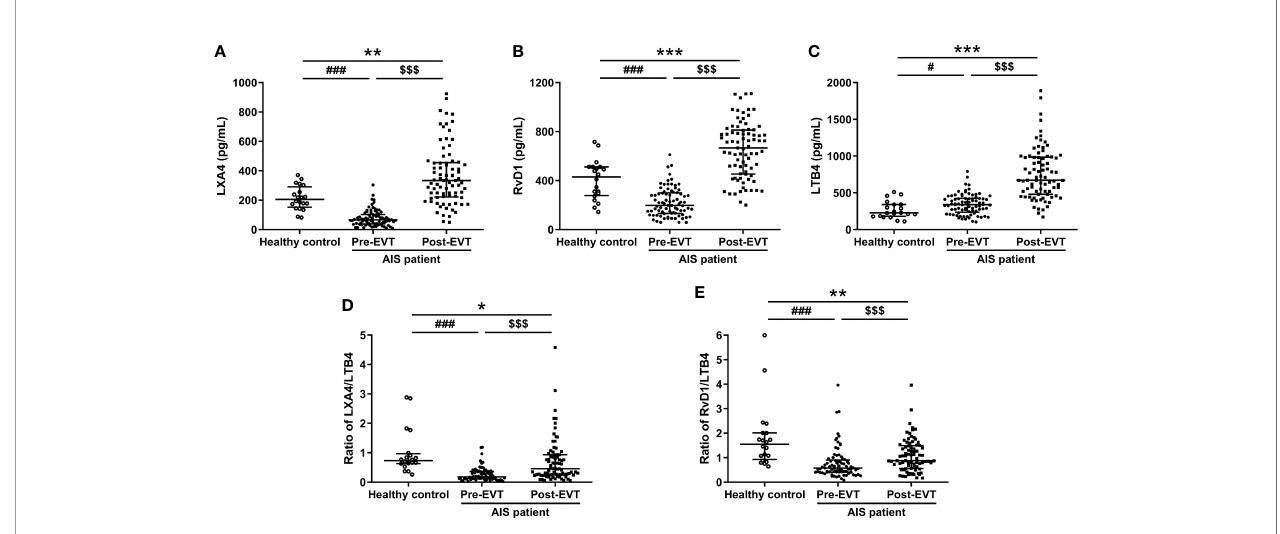
FIGURE 1 | Plasma levels of LXA4 (A) , RvD1 (B) , LTB4 (C) , ratio of LXA4/LTB4 (D) , and ratio of RvD1/LTB4 (E) in healthy controls and EVT-treated AIS patients (pre- and 24 hrs post-EVT). Healthy controls were severed as baseline to analyze temporal pro fi le of plasma lipid mediators in EVT-treated AIS patients. Data were presented as median and IQR. Differences between AIS patients and healthy controls were analyzed using the Mann-Whitney U test or independent-samples t-test (LTB4: healthy control vs. pre-EVT, RvD1: healthy control vs. post-EVT). The paired Wilcoxon signed-rank test was used to analyze dynamic changes of plasma levels of lipid mediators pre- and post-EVT. # p<0.05 and ### p<0.001: healthy control vs. pre-EVT; *p<0.05, **p<0.01, and ***p<0.001: healthy control vs. post-EVT; $$$ p<0.001: pre-EVT vs.